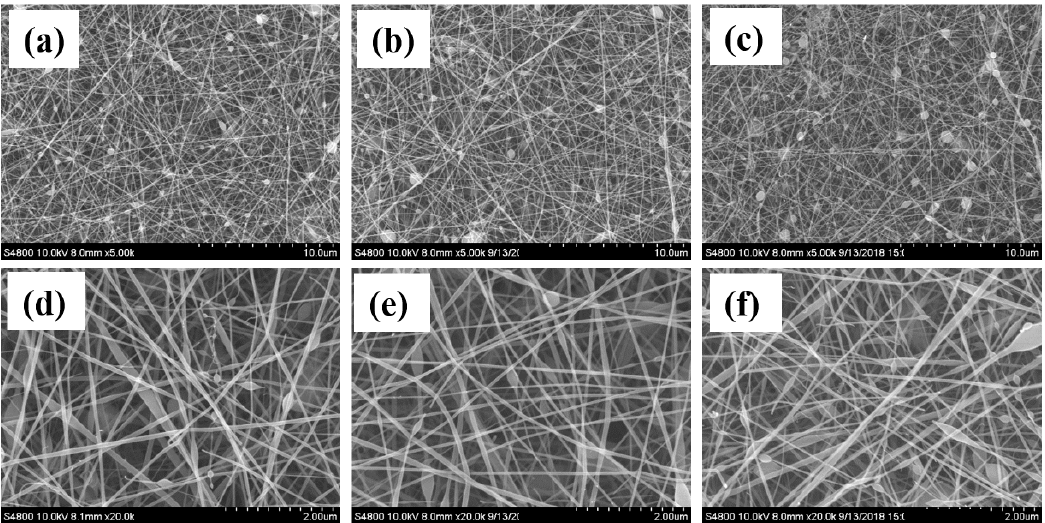
Figure 1. SEM images of SF nanofibers prepared by different electrospinning flow rates, at ( a ) 0.1 mL/h, ( b ) 0.15 mL/h, ( c ) 0.2 mL/h, ( d ) 0.1 mL/h, ( e ) 0.15 mL/h, ( f ) 0.2 mL/h. Note: Scale bars for ( a – c ) are 10 µm. Scale bars for ( d – f ) are 2 µm. Electric field: 1.2 kV/cm. Needle gauge: 20. SF concentration: 10 wt.%.